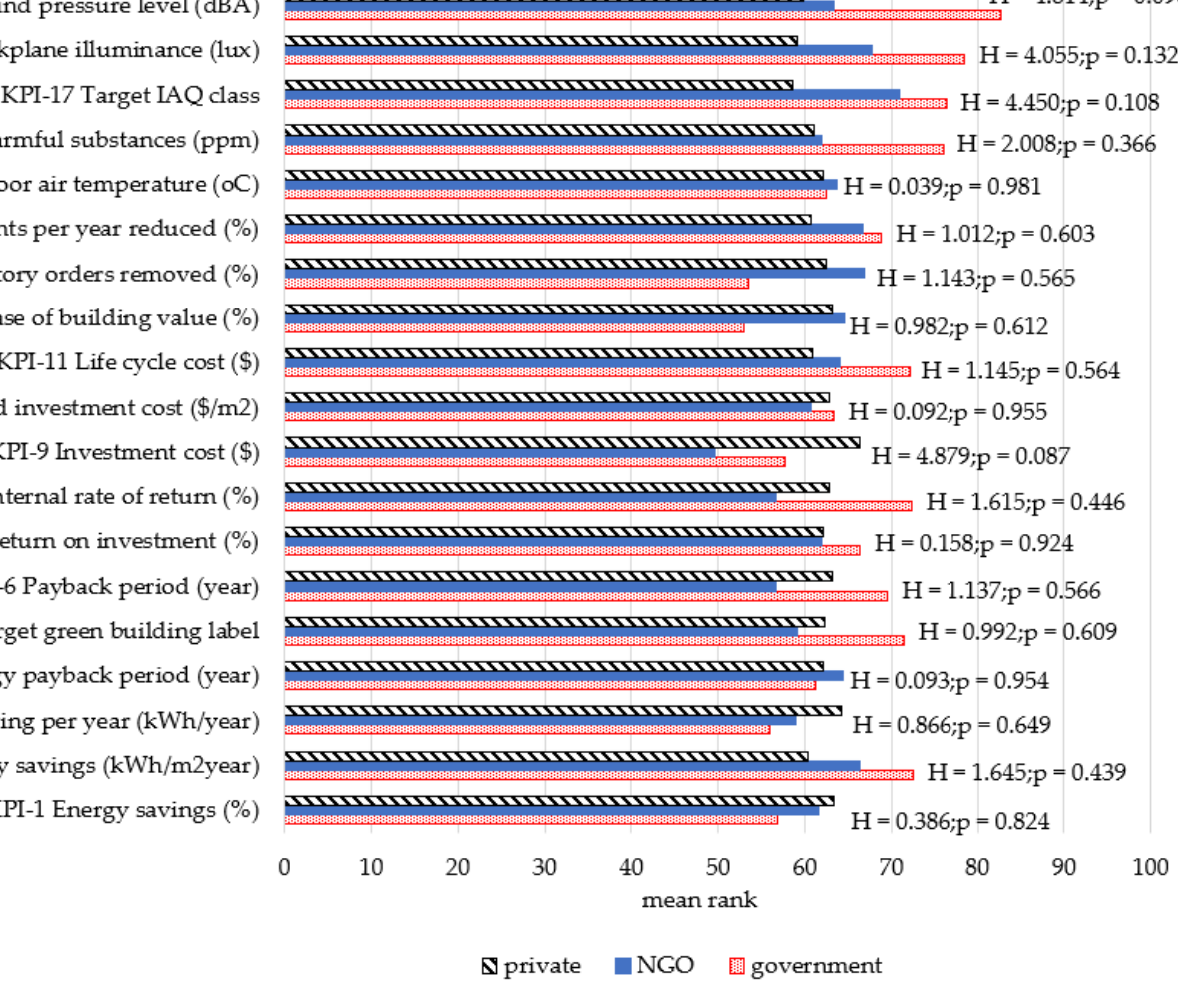
Figure A2. Kruskal – Wallis H-test results of G3 (nature of organisation). Figure A2. Kruskal–Wallis H-test results of G3 (nature of